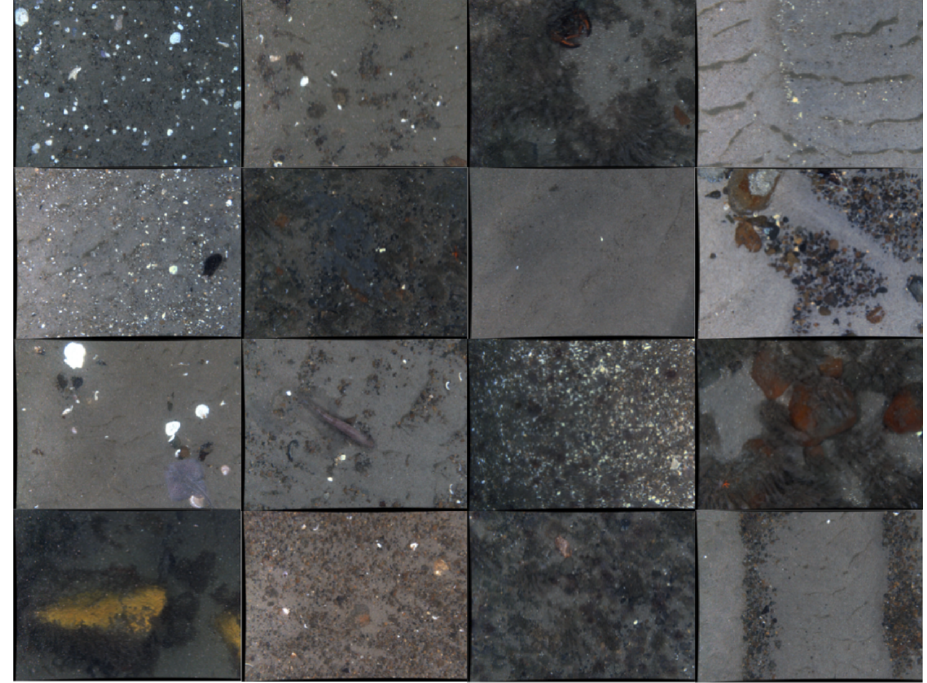
Figure 37. A selection of HabCam images collected during the 2015 MBES survey that indicate the presence of different biotopes surrounding the bedforms area. Each image covers an area of approximatively 1 m 2